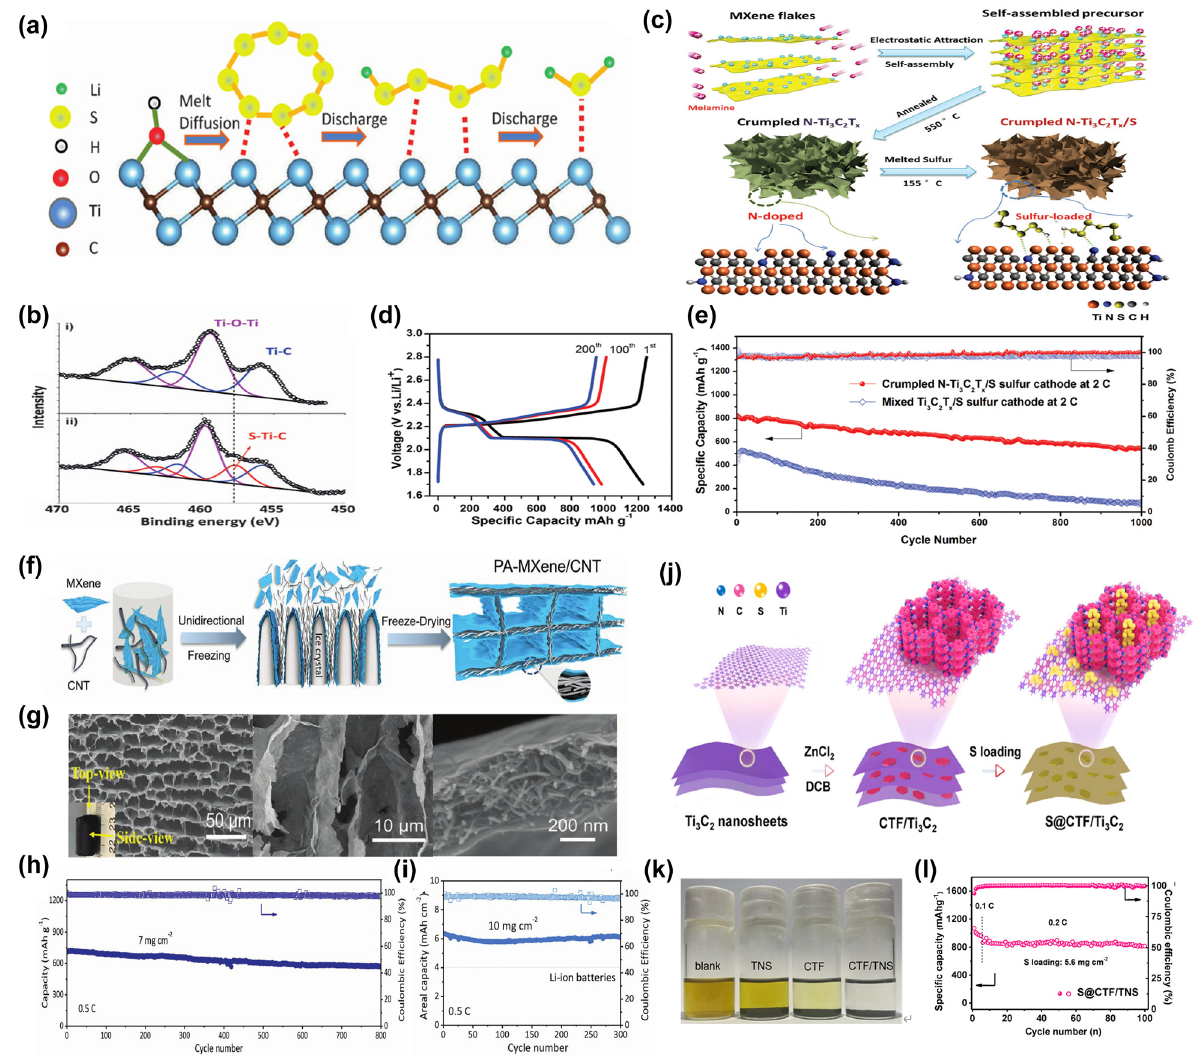
Figure 5: Preparation process, structure and electrochemical performance of S/MXene cathode for Li-S battery. (a) Replacement of the Ti-OH bond on the MXene surface with a S-Ti-C bond on heat treatment or by contact with polysulfides. (b) Ti 2p C sheets and (ii) 70 S/Ti C composite. Reproduced with permission [100]. Copyright 2015, WILEY-VCH. (c) Illustration of spectra of the (i) Ti 2 2 C T /S composites. (d) Typical charge and discharge profiles of crumpled N-Ti C T /S electrodes for the 1st, synthesis of the crumpled N-Ti 3 2 3 2 x x C T /S electrodes and mixed-Ti C T /S electrodes at 2C for 1000 100th, and 200th cycle at 0.2C. (e) Cycling performances of crumpled N-Ti 3 2 3 2 x x cycles (1C = 1673 mA g − 1 ). Reproduced with permission [101]. Copyright 2018, WILEY-VCH. (f) The schematic of the assembly process of the PA-MXene/CNT aerogel by the unidirectional freeze-drying. (g) SEM images of PA-MXene/CNT. (h, i) Cycling performance of PA-MXene/CNT-50 electrode with sulfur loadings of 7 and 10 mg cm − 2 at 0.5 C. Reproduced with permission [96]. Copyright 2021, Wiley-VCH GmbH. (j) Schematic illustration of the synthetic process of the 2D CTF/TNS heterostructures and the S@CTF/TNS composites. (k) Digital S adsorption. (l) Cycling performance of the S@CTF/TNS electrode with a high areal sulfur loading of 5.6 mg cm − 2 . Reproduced photos of Li 2 6 with permission [104]. Copyright 2020, Elsevier